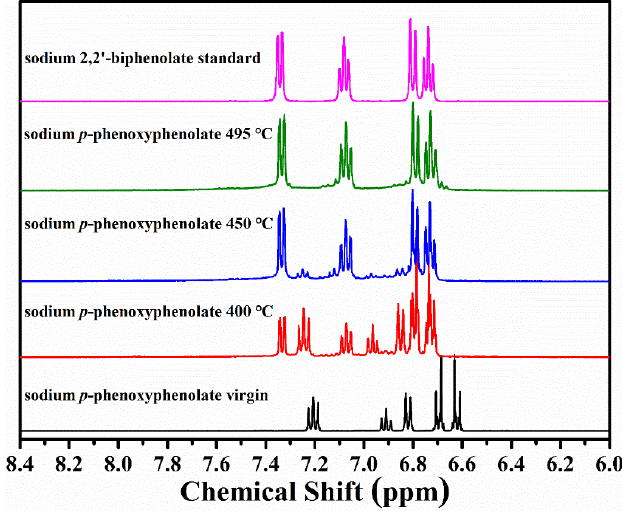
Figure 11. 1 H NMR spectra of thermally treated sodium p -phenoxyphenolate at different temperatures.